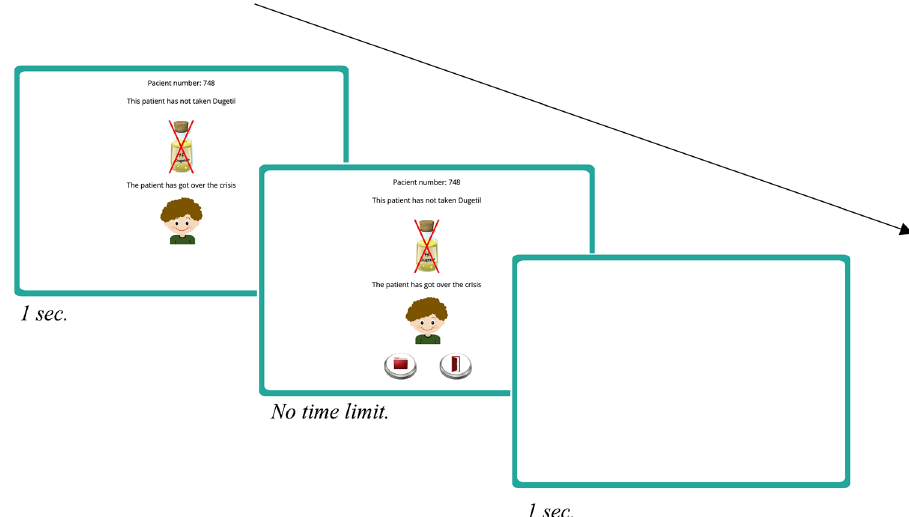
Figure 7. Schematic procedure of the contingency learning task used in Study 2 (this figure has been made up by combining actual screenshots from the original task).